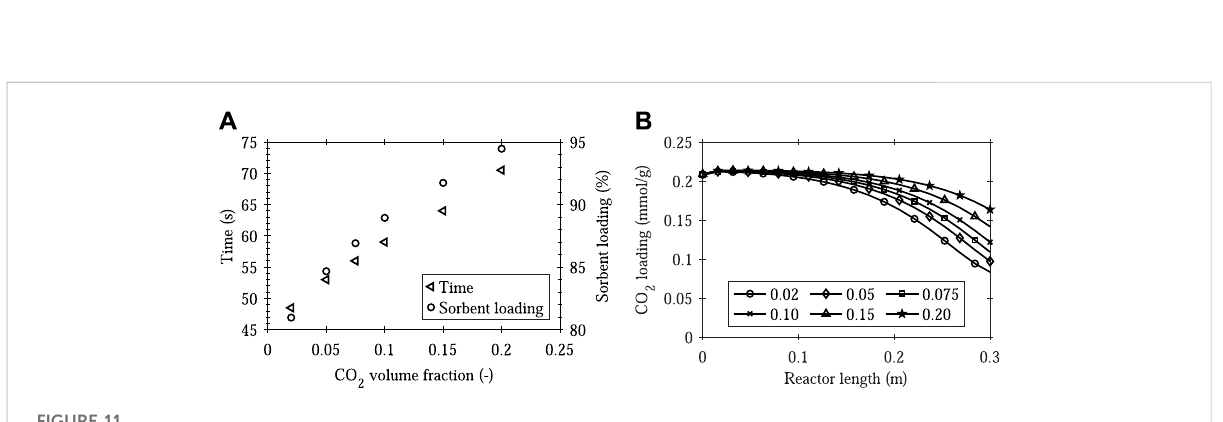
FIGURE 11 MATLABSimulinkresultsforthepilotplantbasecasesimulationwithvarious y {CO Time span of M2, and relative sorbent loading at the end of M2 as a function of the threshold CO 2 volume fraction (cycle 5 in chamber 1), (B) CO 2 loading at the end of M2 over the reactor length for various CO 2 volume fraction thresholds (cycle 5 in chamber 1).